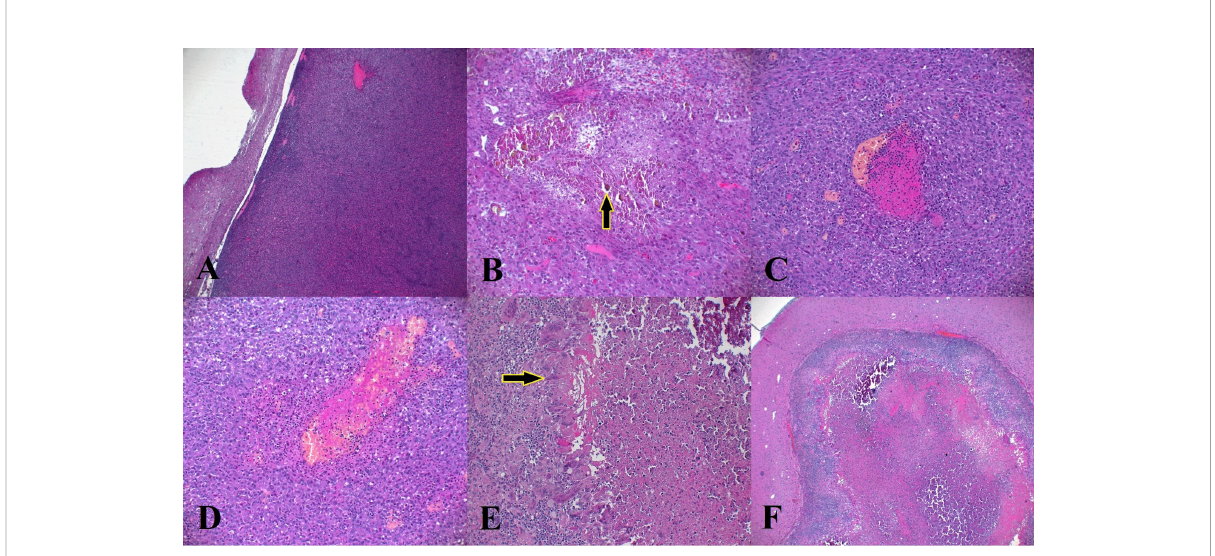
FIGURE 5 Microscopic fi ndings of U87 tumor in the 3 groups. (A) Delimited tumor from the adjacent parenchyma. Tumor is highly cellular, (B) presence of Ho Crystals (arrow) located in necrotic areas within the tumor, (C, D) coagulative necrosis located around the blood vessels in control group, (E) Granulomatous in fl ammation in group 1 composed of macrophages and multinucleated giant cells, (F) severe necrosis in the tumors treated with 166 Ho (group